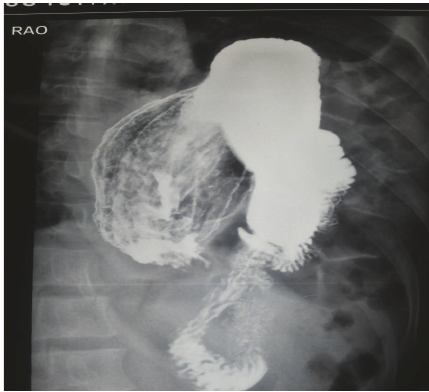
Figure 2: Barium enema showing transverse colon and splenic flexure in left hemithorax.